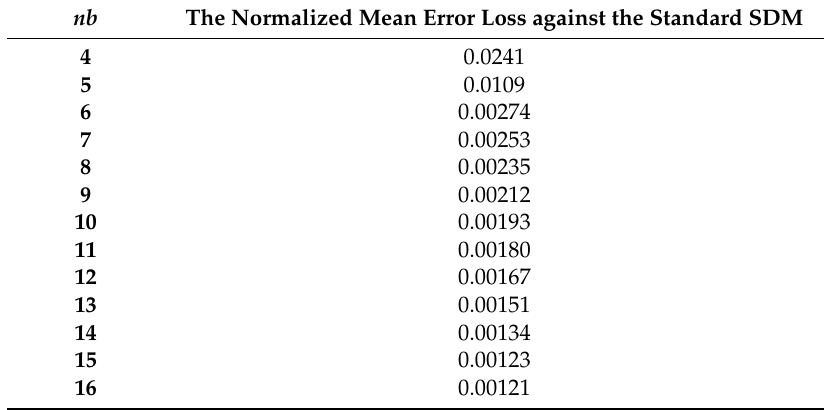
Table 3. The normalized mean error loss against the standard SDM for different choices of nb . nb The Normalized Mean Error Loss against the Standard SDM